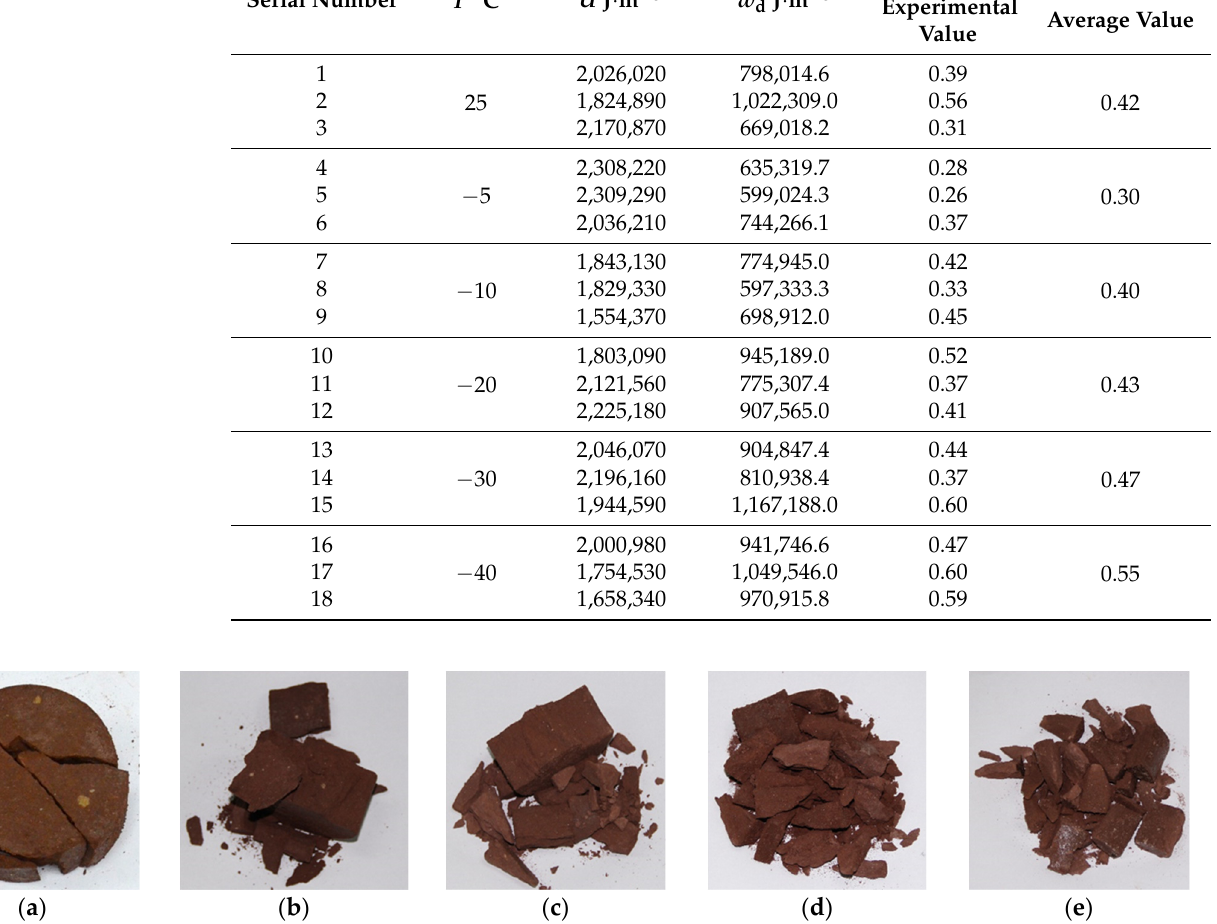
Figure 6. Failure modes of red sandstone at different negative temperatures. ( a ) − 5 °C, b ) − 10 °C, ( c ) − 20 °C, d ) − 30 °C, ( e ) − 40 °C.